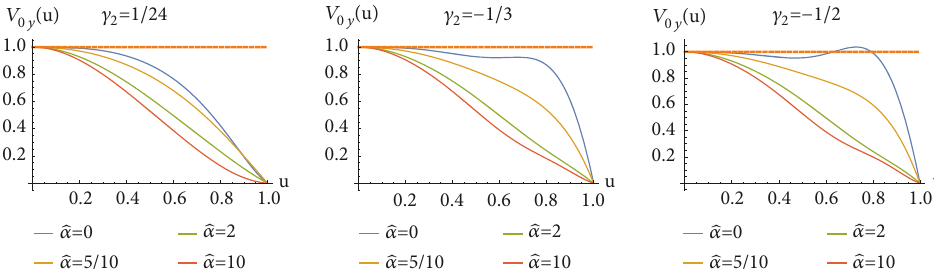
Figure 15: The potentials 𝑉 0𝑦 (𝑢) for sample 𝛾 2 and ̂𝛼 , which constrain 𝛾 2 in the region of 𝛾 2 ∈ [−1/3,1/24]